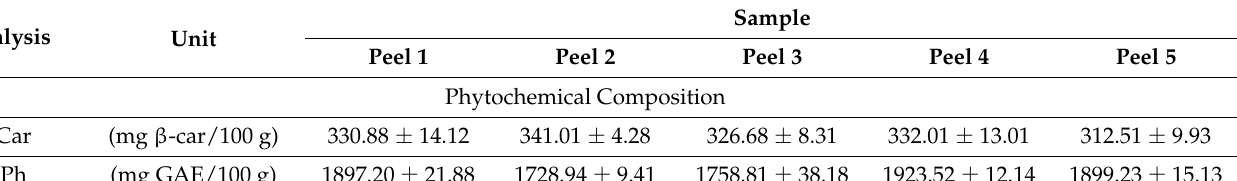
Table 2. The obtained results for peel